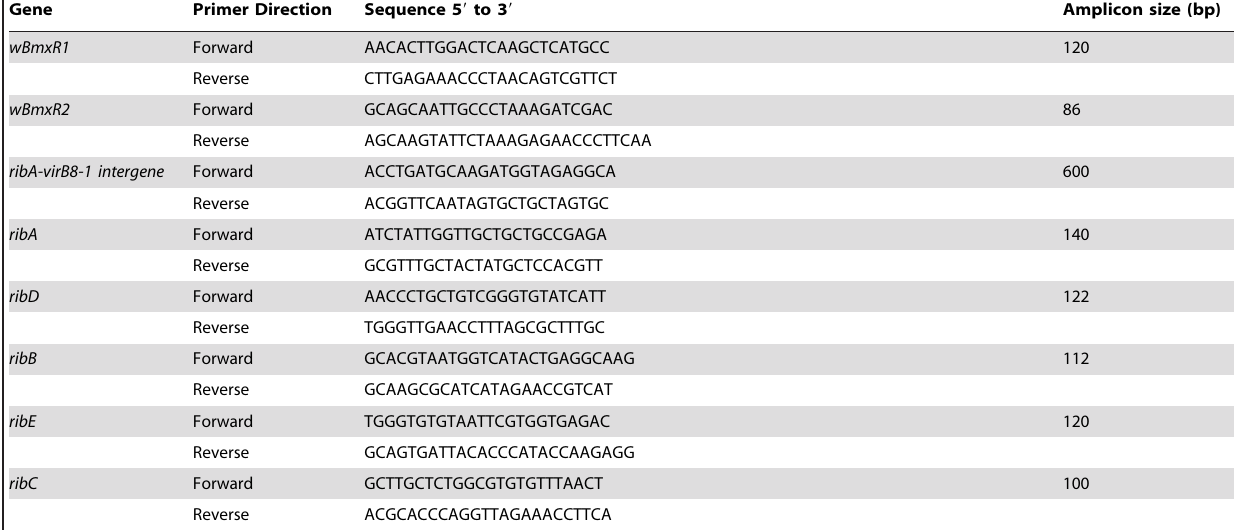
Table 1. Primers used for RT-PCR.